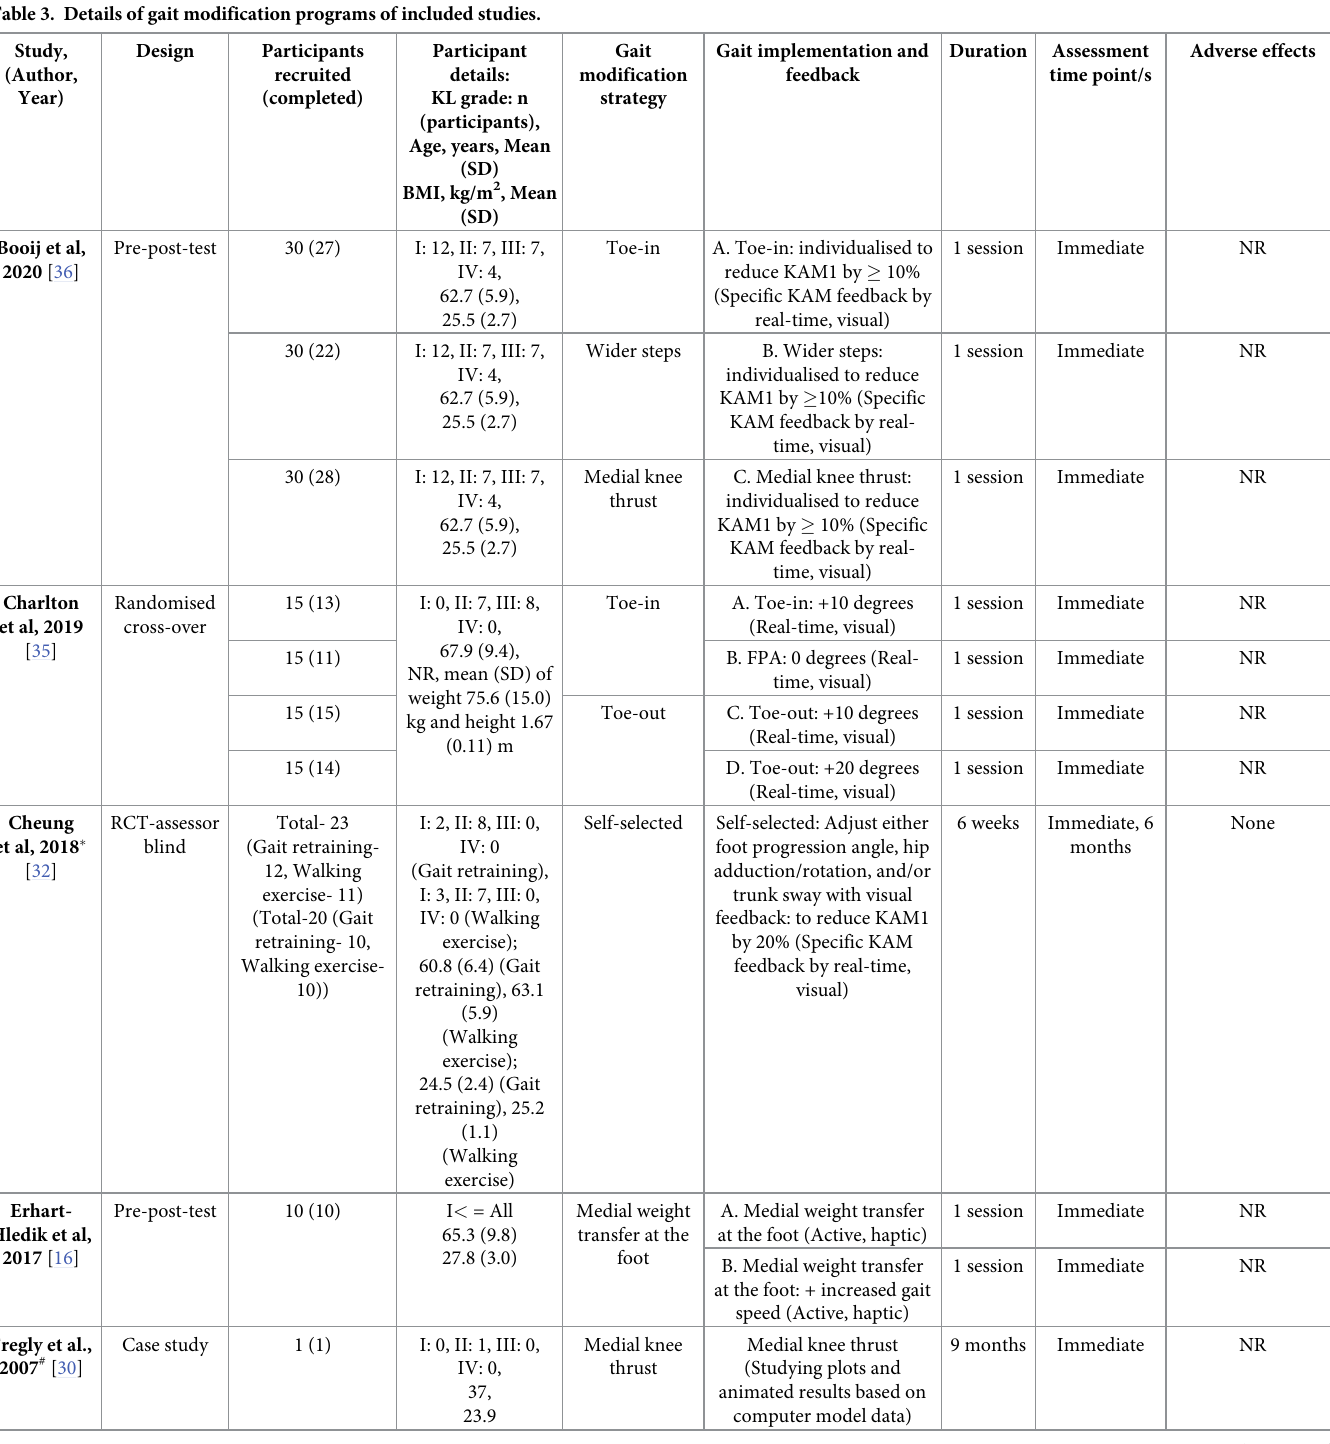
Table 3. Details of gait modification programs of included